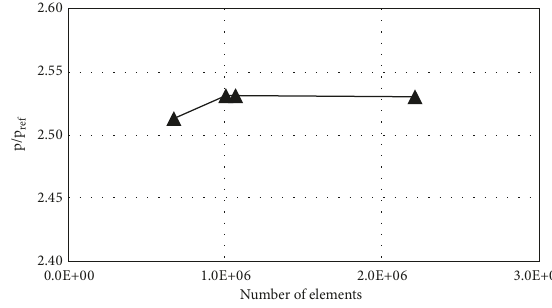
Figure 6: Mesh convergence.